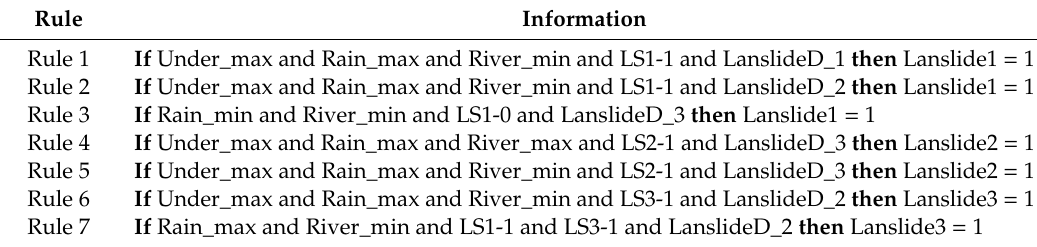
Table 2. Description of some association rules (minsupp =